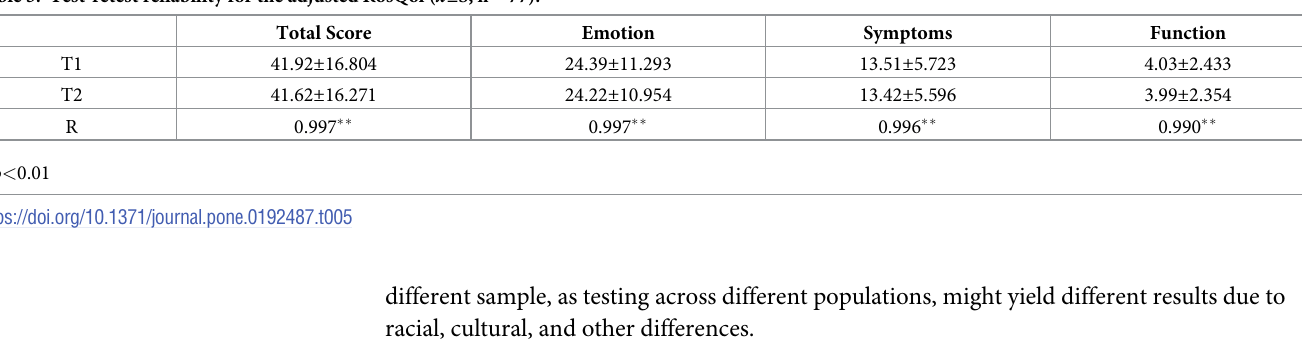
Table 5. Test-retest reliability for the adjusted RosQol ( (cid:22) x ±S, n = 77).